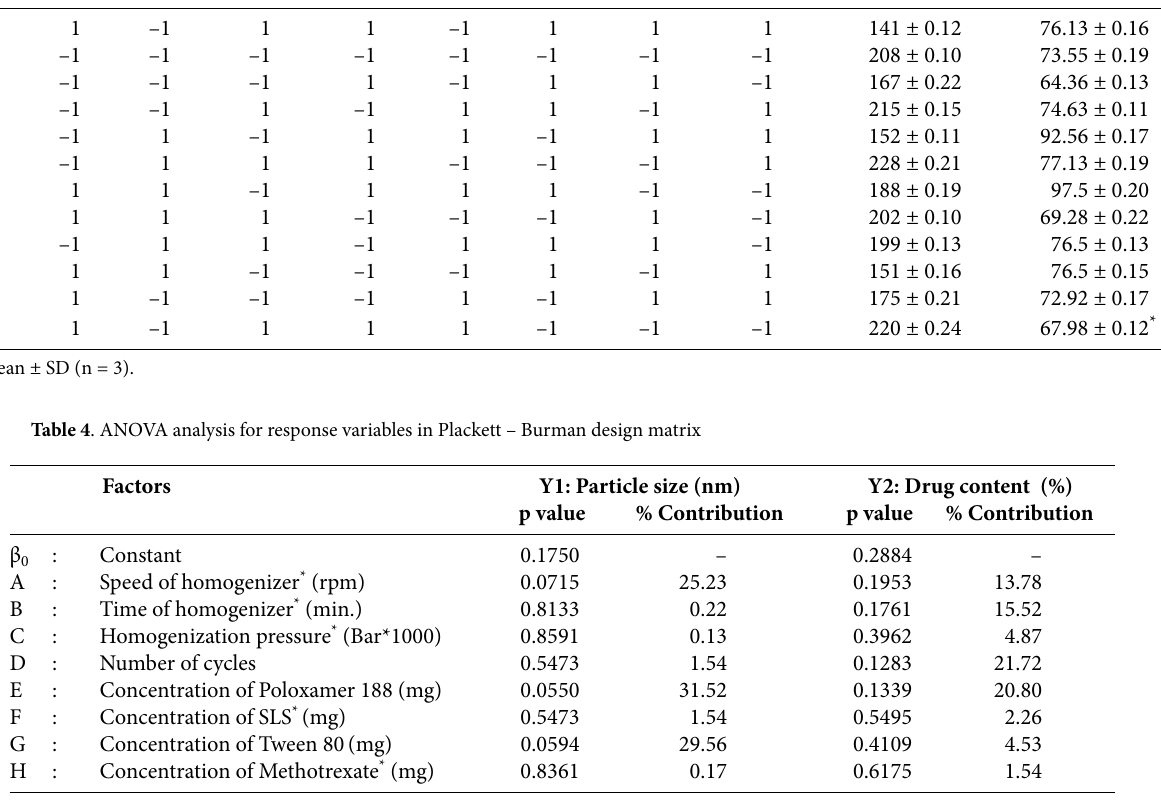
Table 3. Plackett–Burman experimental design matrix with observed values of response variables.